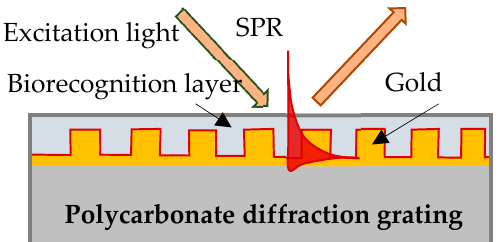
Figure 1. SPR chip: gilded di ff raction grating with immobilized Hb/Mb.